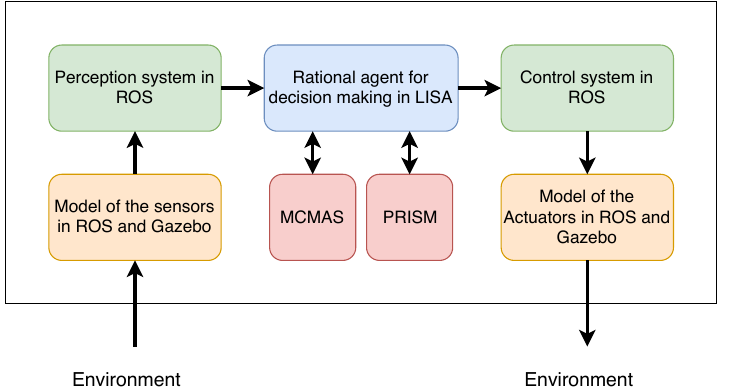
Figure 1. Block diagram showing the different components of the autonomous vehicle system in simulation. Blocks in green and yellow represent the sensing and actuating systems, the block in blue represents the rational agent that communicate with the verification system (MCMAS and